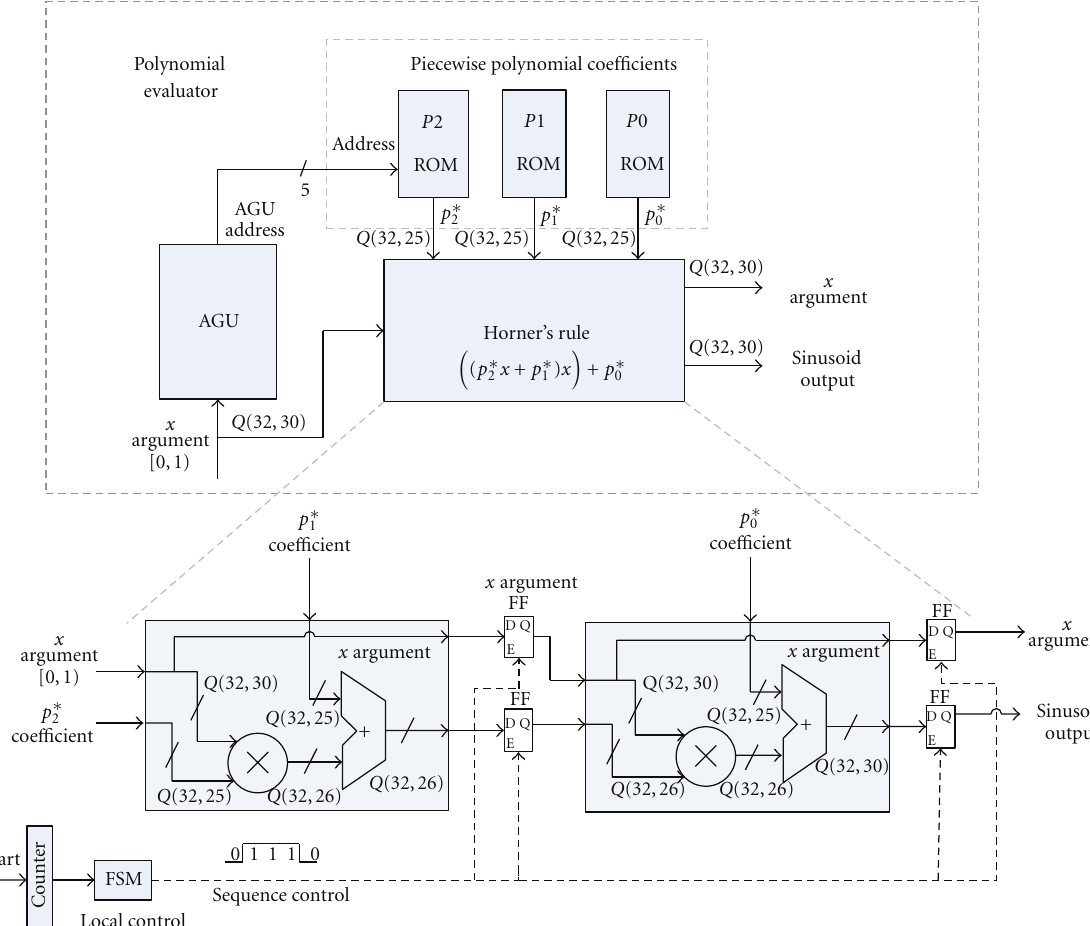
Figure 4: Architecture of the poly-evaluator